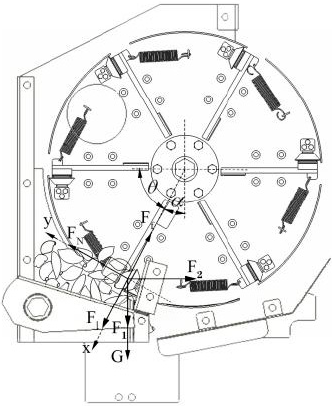
Figure 5. The diagram of force analysis of seeding process. Note: G is the gravity force of garlic species, (N); F N is the support force of the seed-taking spoon to the garlic seed, N; F f is the friction force between the garlic seed and the seed-taking scoop, N; F 1 is the longitudinal combined pressure of the garlic seed, N; F 2 is the horizontal combined pressure of the garlic seeds, N; α is the angle between the x axis and the direction of gravity, ( ◦ ); θ is the angle between F f and F 2 , ( ◦